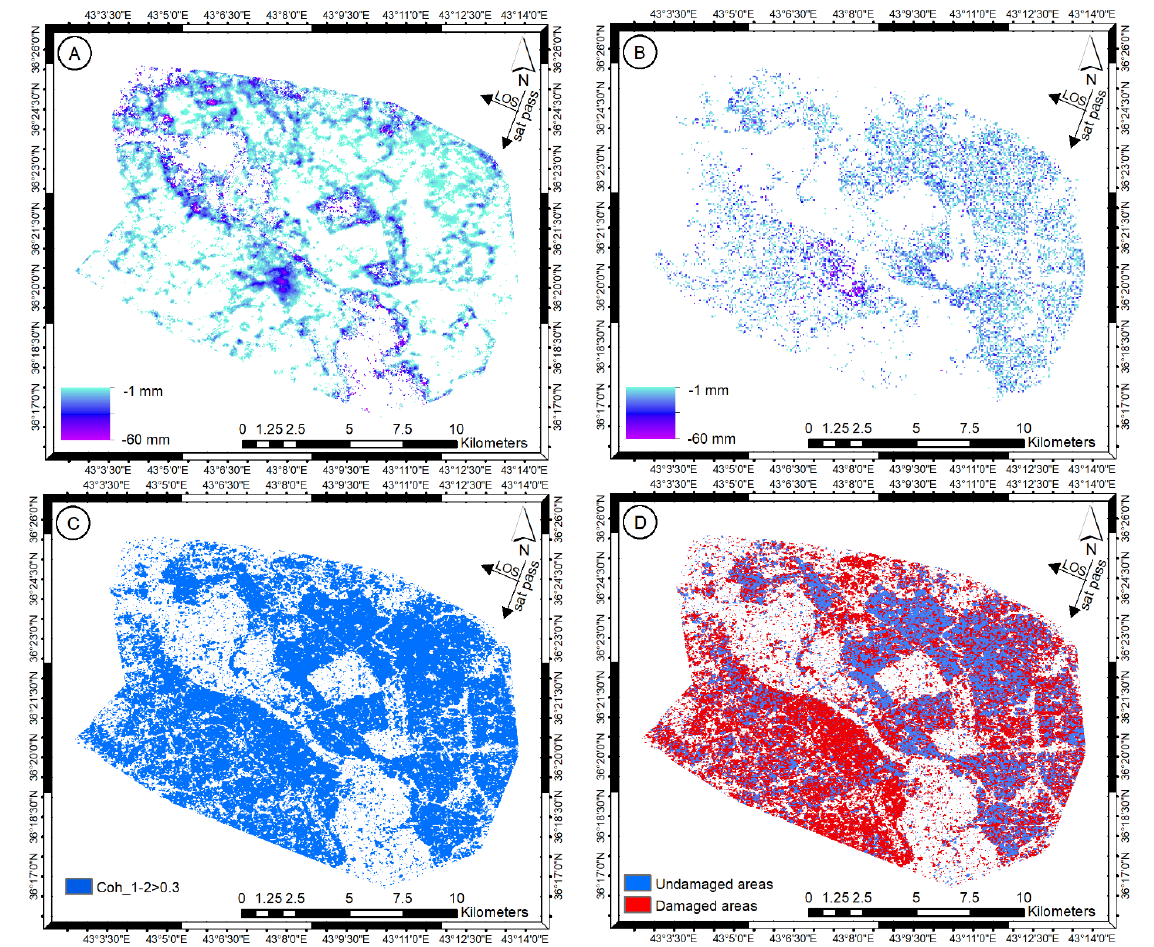
Figure 7. Estimation of damaged regions in Mosul. ( A ) SBAS and ( B ) PSI displacement maps masked for pixel values higher than − 1; ( C ) Coherence-masked map calculated between the first and second images masked for pixel values lower than 0.3, indicating man-made structures and ( D ) damaged and undamaged areas extracted from the coherency map estimated from images at positions 1–2 and 1–35.